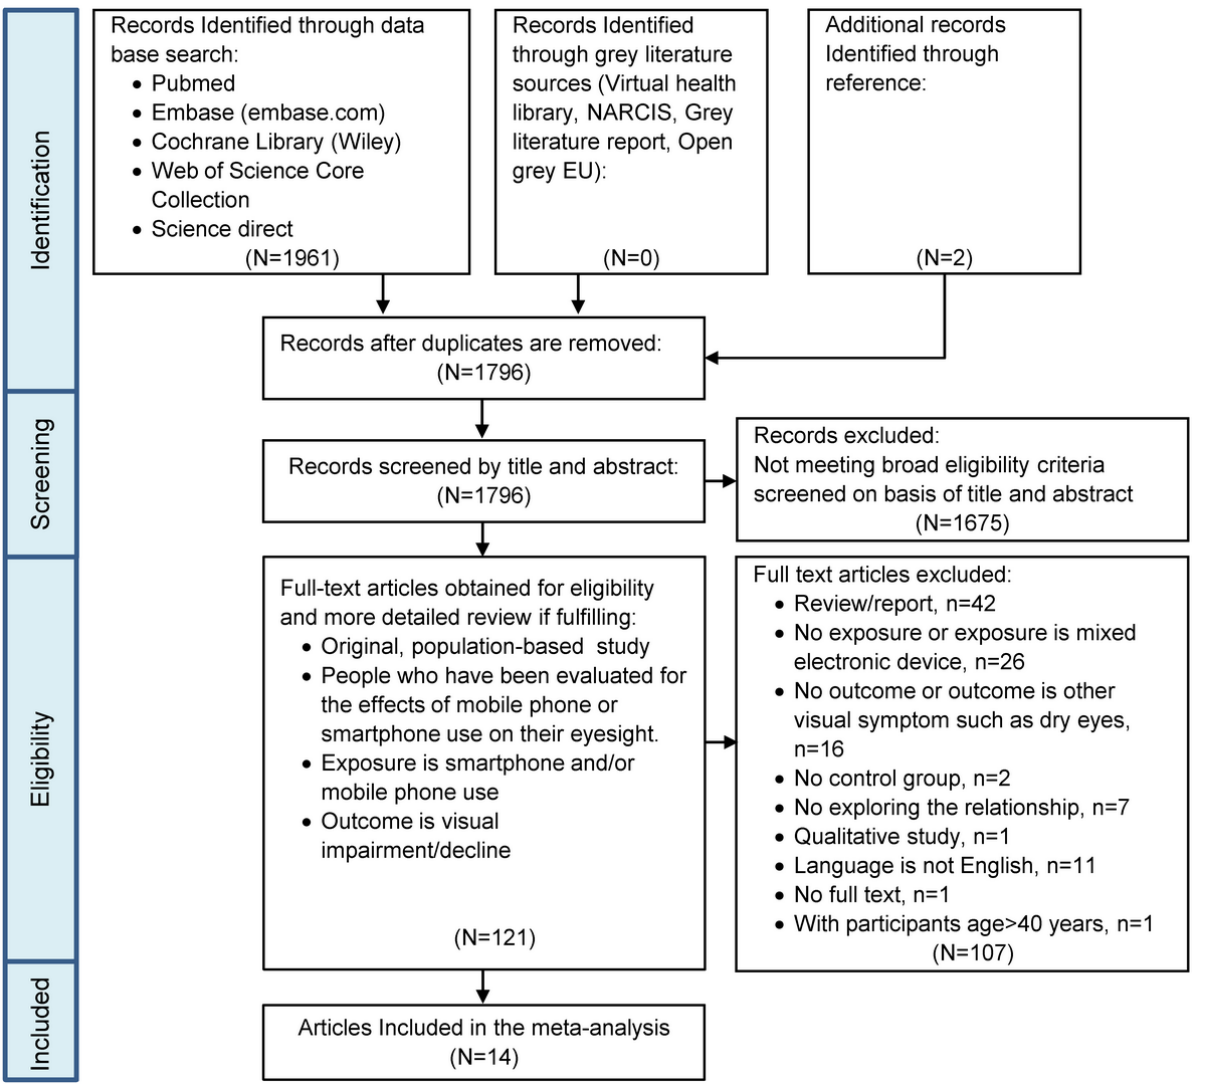
Figure 1. PRISMA (Preferred Reporting Items for Systematic Reviews and Meta-Analyses) flow diagram for screening and selection of articles on smartphone overuse and visual impairment in children and young